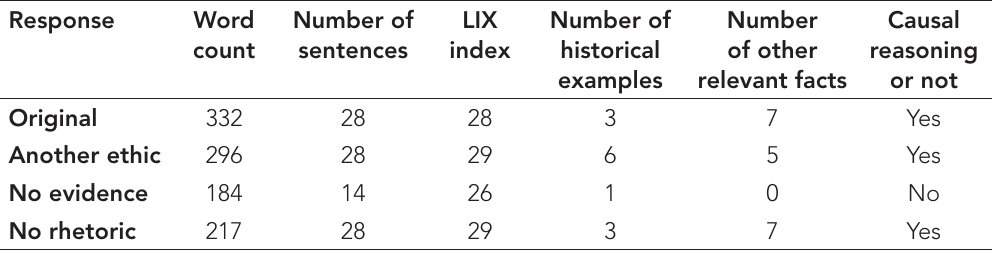
Table 1: The form of the responses